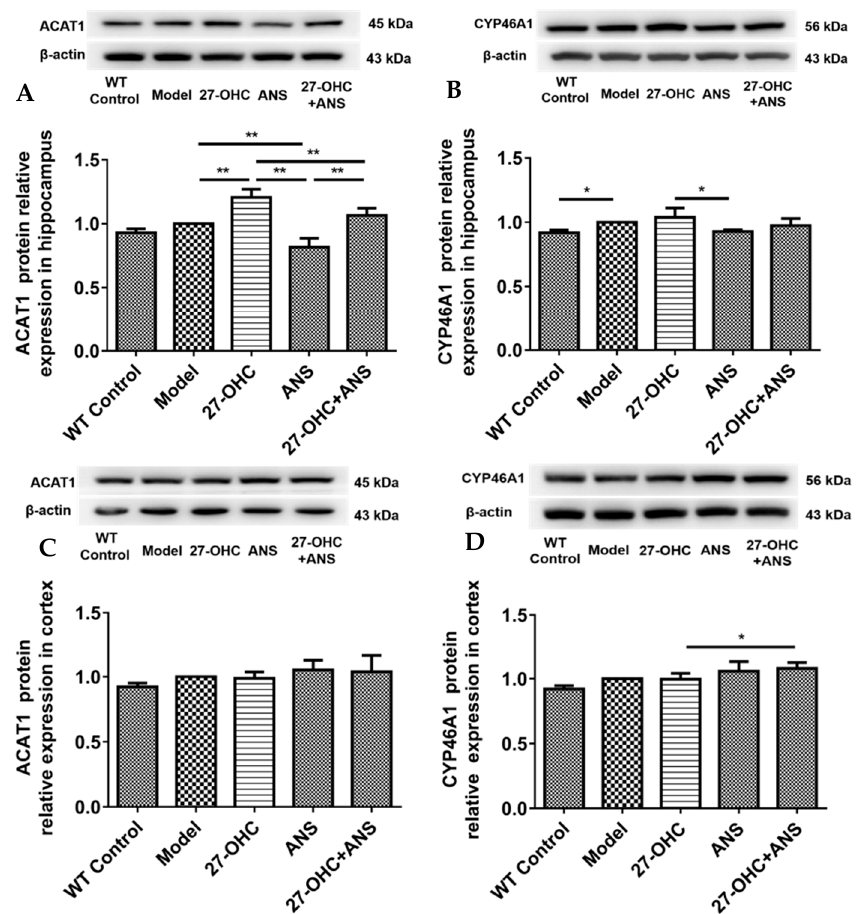
Figure 8. Expression of brain cholesterol conversion-related proteins: ( A ) ACAT1 protein expression in the hippocampus; ( B ) CYP46A1 protein expression in the hippocampus; ( C ) ACAT1 protein expression in the cortex; ( D ) CYP46A1 protein expression in the cortex; n = 5/group. Densitometric analyses were normalized to β -actin. All data are shown as mean ± SD. * p < 0.05; ** p < 0.01 (one-way ANOVA).